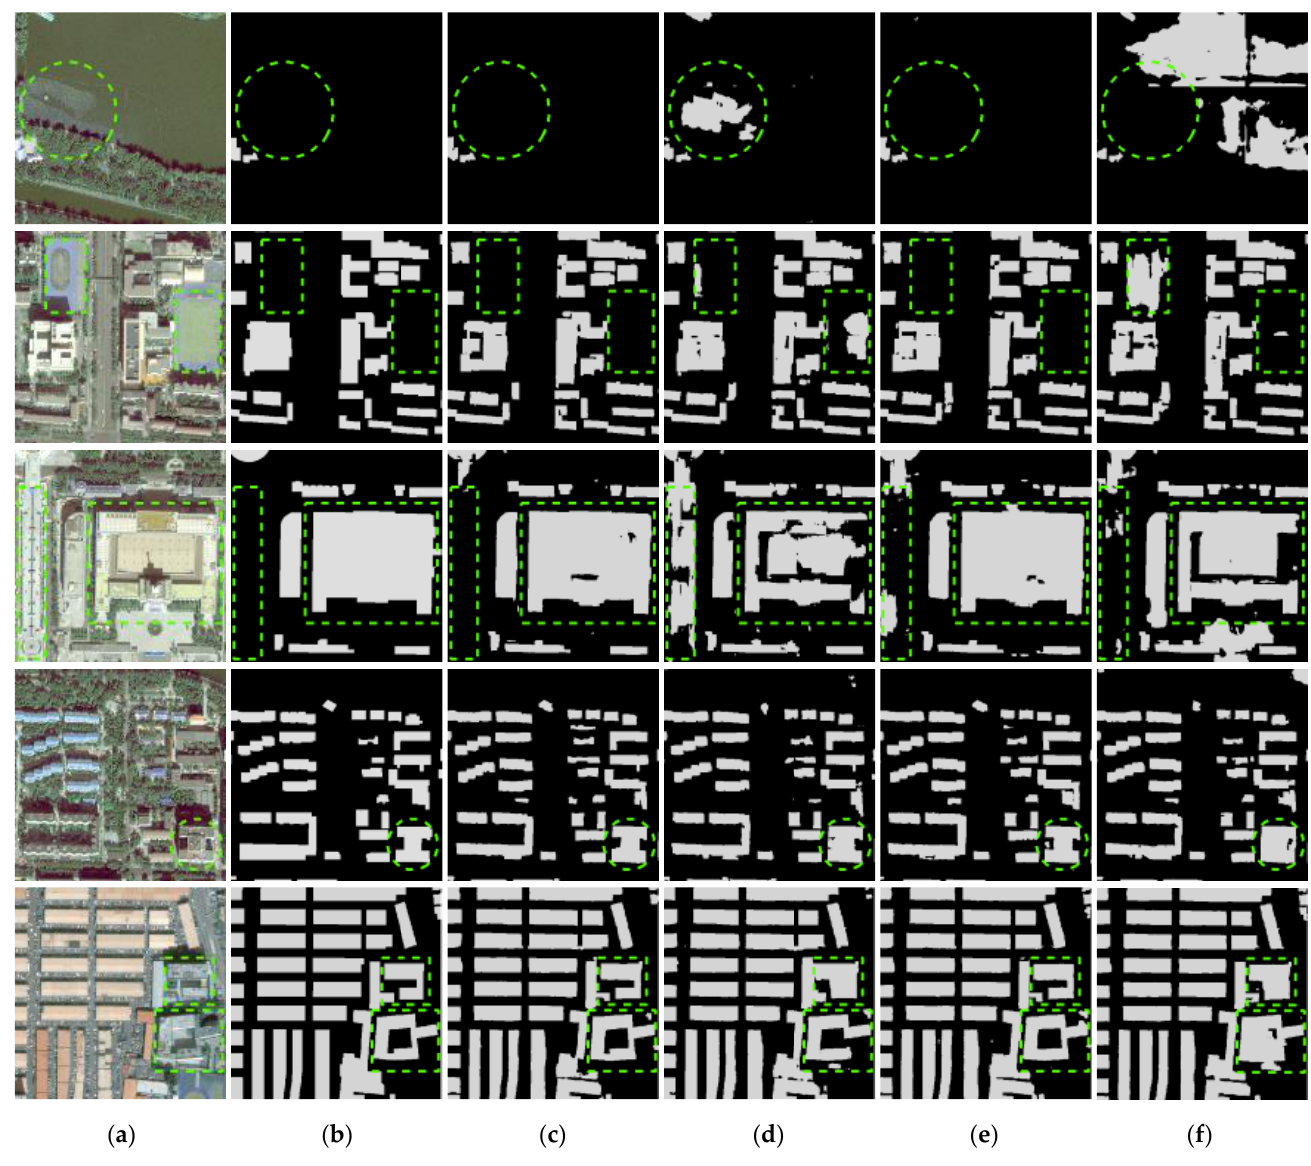
Figure 9. Building extraction results of models with different inputs. ( a ) Image ( b ) Label ( c ) M1: NIR + nDSM + RGB ( d ) M2: NIR + RGB ( e ) M3: nDSM + RGB ( f ) M4: RGB.